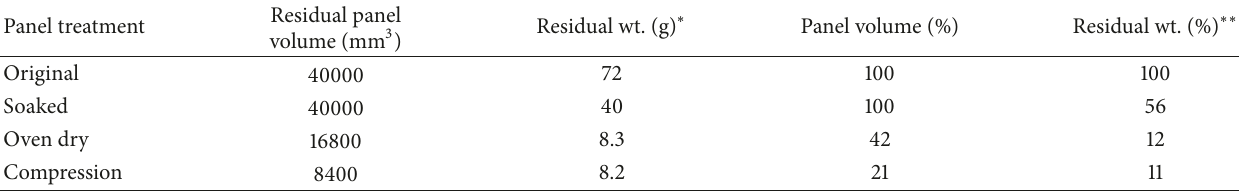
Table 3: Dimensional and weight changes of LC panels during processing.